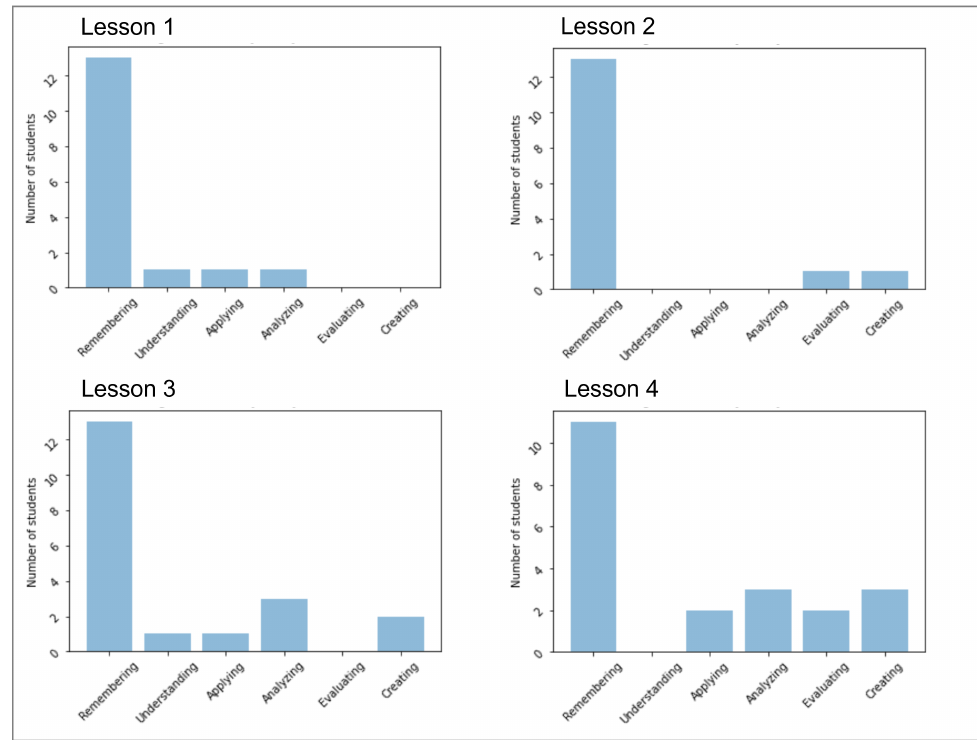
Figure 11. Students’ learning level in each lesson according to Bloom’s